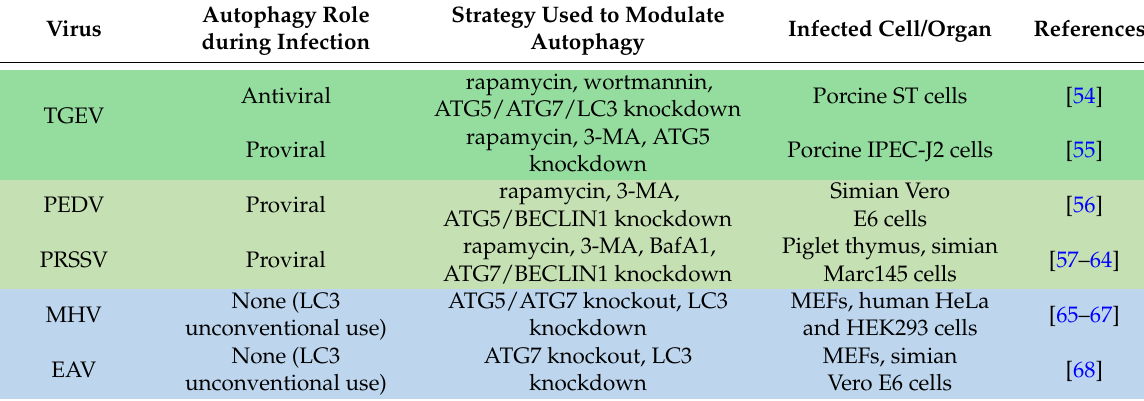
Table 1. Summary of the current knowledge on autophagy contribution over the course of Arteriviruses and Coronaviruses